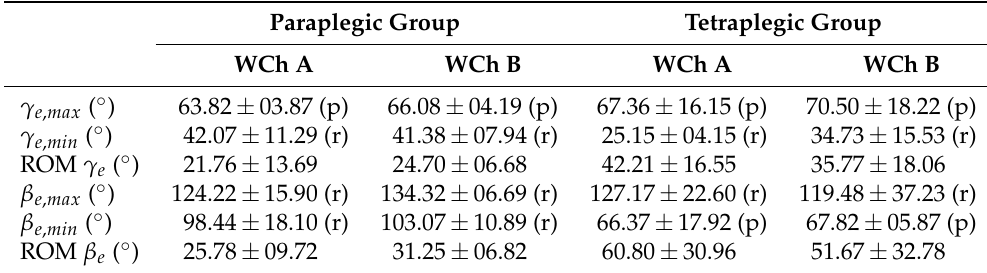
Figure 8. Forces and moments that show significance on the elbow between paraplegics and tetraplegics when propelling wheelchair B. FyMax represents the maximum value of lateral force on the elbow, FzMax shows the maximum superior force on the elbow. MyMax shows the maximum value of the flexion moment. In all cases, the values for paraplegics (_p) and tetraplegics (_t) are shown. Table 11. Kinematic variables on the elbow: maximum, minimum and ROM values (mean ± SD) and the propulsion phase in which they happen: pushing (p) or recovery phase (r).